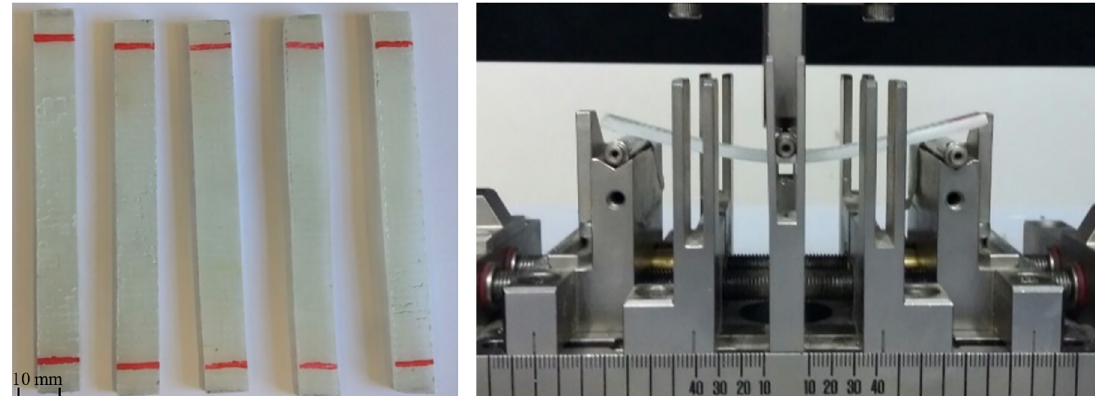
Figure 2. Flexural test of sandwich composite specimens.